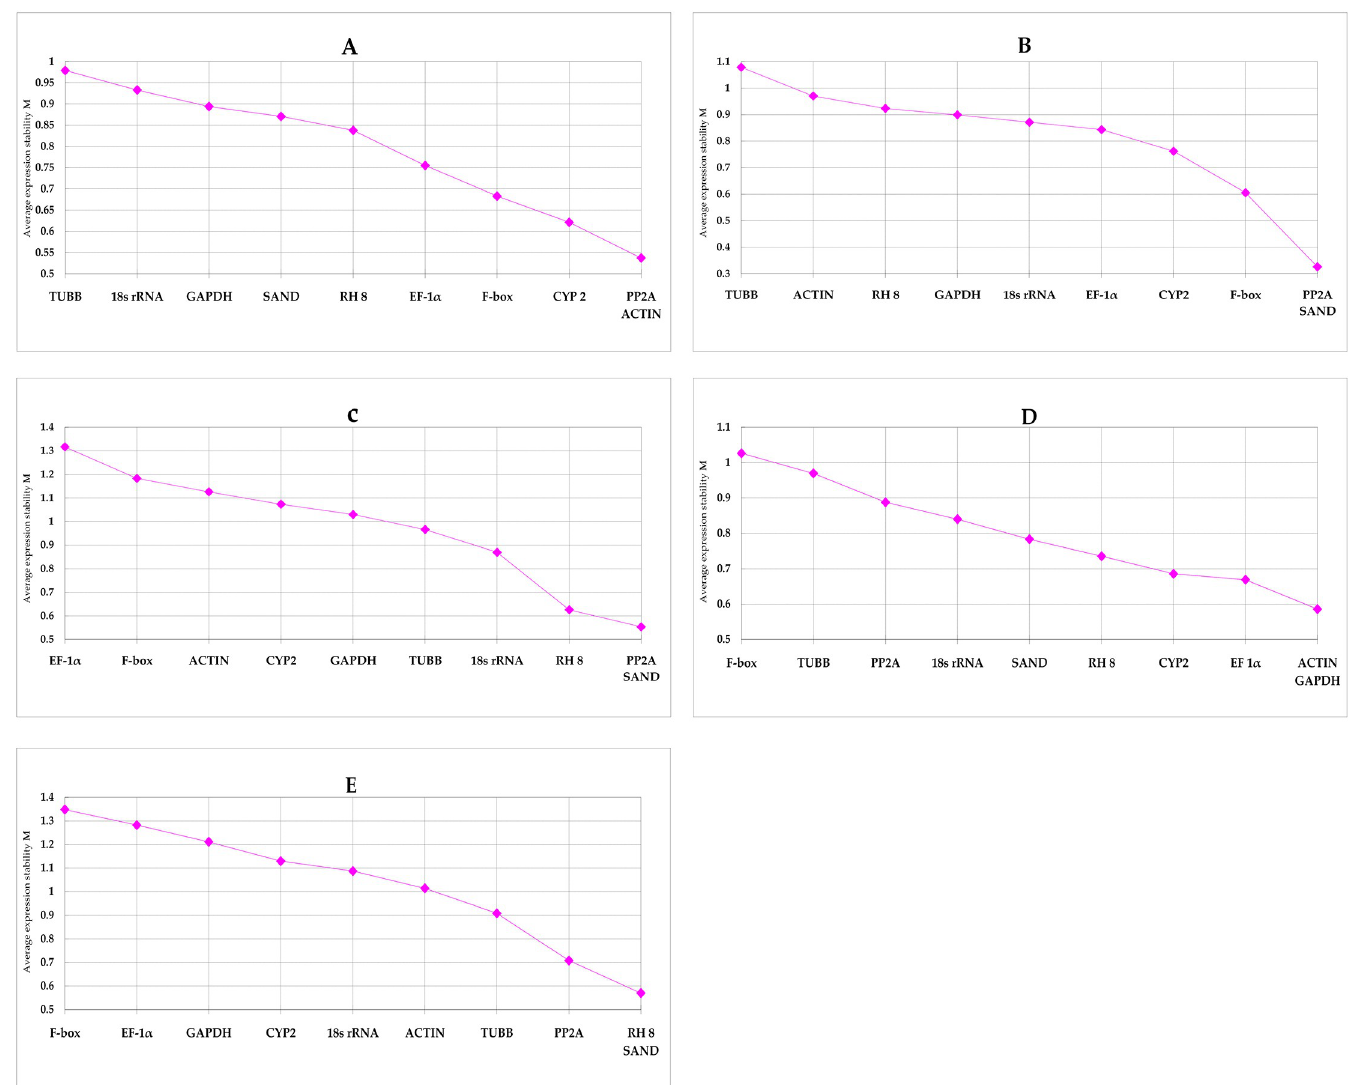
Fig 2. The average expression stability value (M) of the candidate reference genes in the five sample sets obtained by geNorm. (A) different cultivars; (B) different organs of the same genotype; (C) leaves treated by three abiotic stresses; (D) roots treated by three abiotic stresses; (E) ‘leaves + roots’ treated by three abiotic